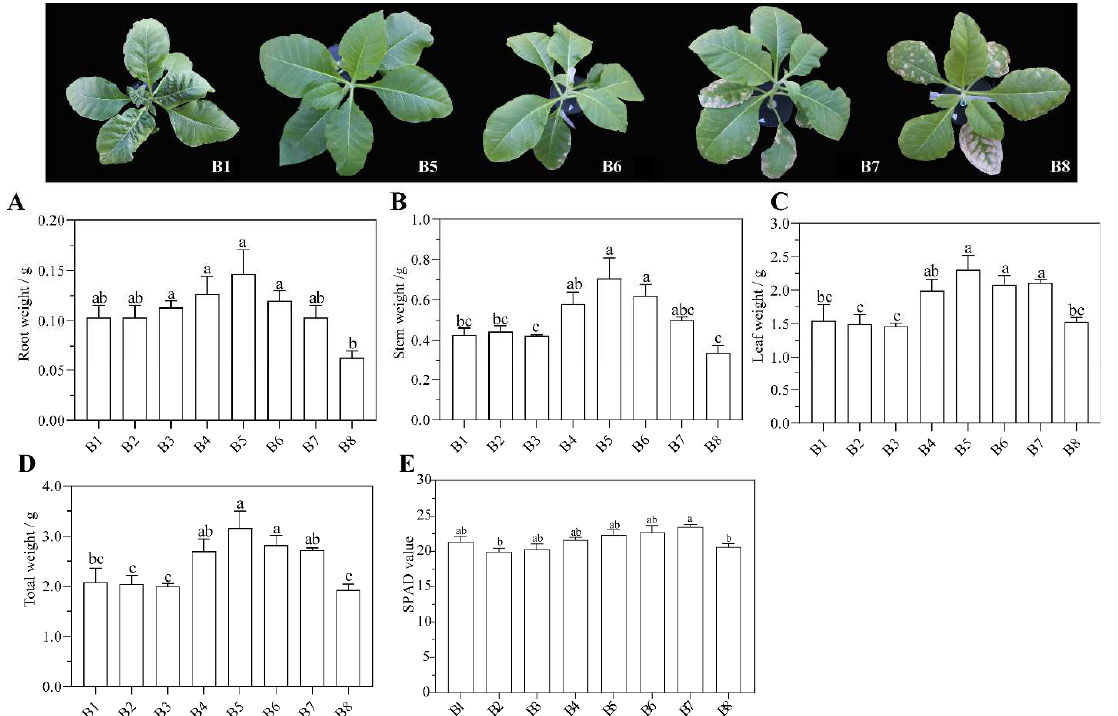
Figure 1. Effects of B on the growth performance of tobacco seedlings. Note: growth statuses of flue- cured tobacco seedlings under different B concentrations: 0.00 mmol·L −1 (B1), 5.00 mmol·L −1 (B5), 10.00 mmol·L −1 (B6), 20.00 mmol·L −1 (B7), 40.00 mmol·L −1 (B8). B1 treatment showed B deficiency 10.00 mmol · L − 1 (B6), 20.00 mmol · L − 1 (B7), 40.00 mmol · L − 1 (B8). B1 treatment showed B